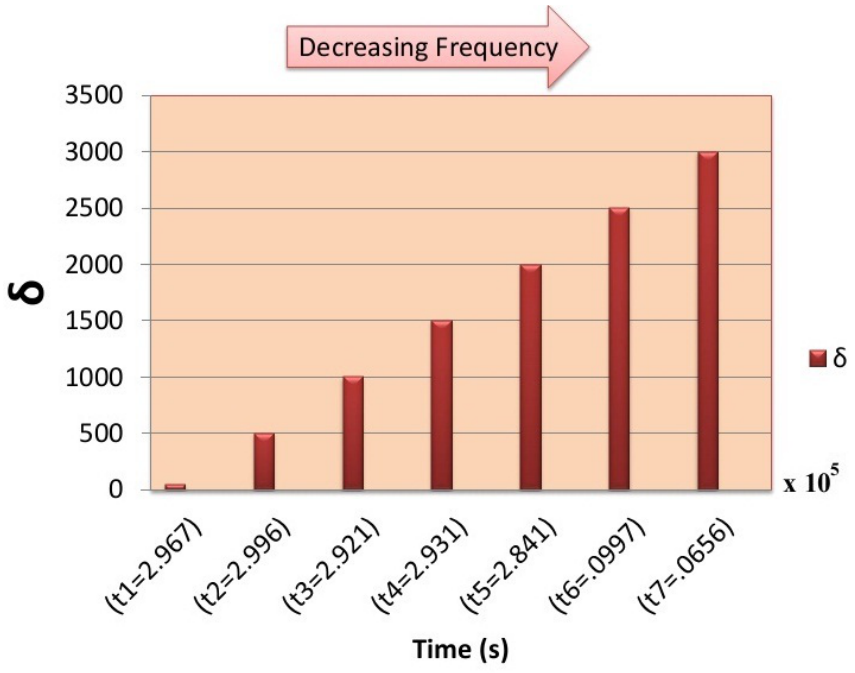
Figure 5. Effect of feedback coupling coefficient δ on the frequency and spiking interval of post- synaptic